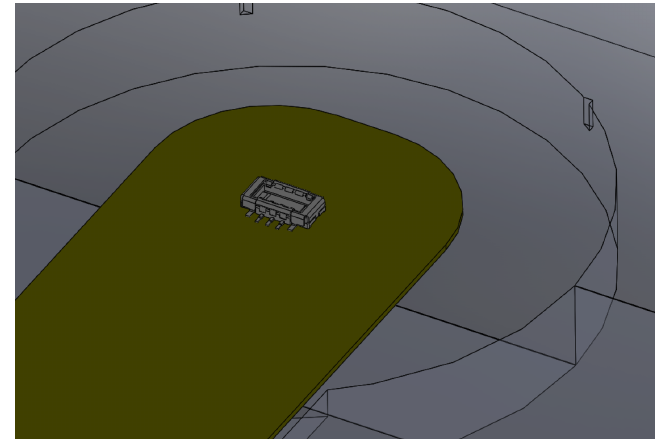
Figure 3. A detailed view of the male connector.